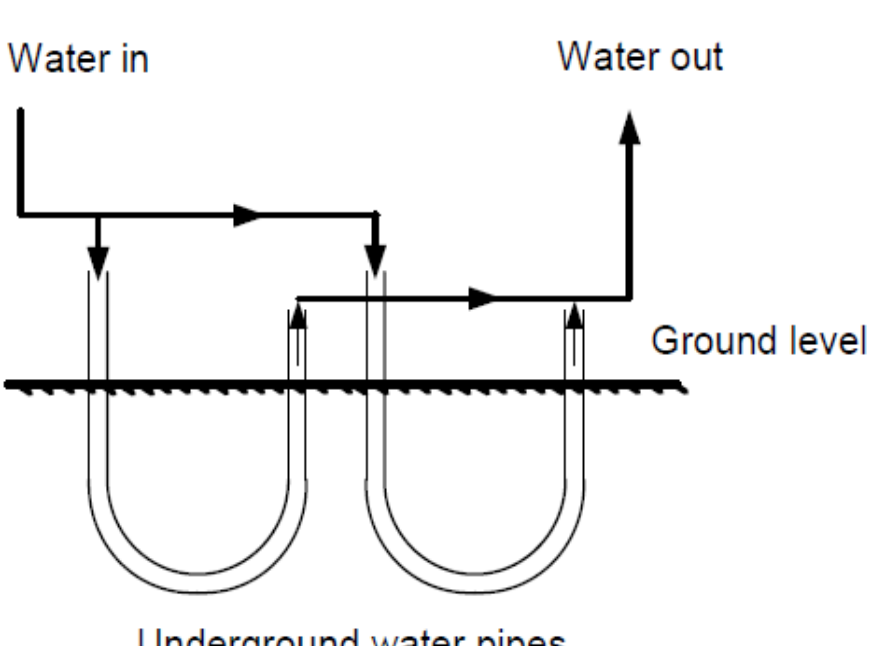
Figure 5. Schematic of a ground coupled water cooling system.